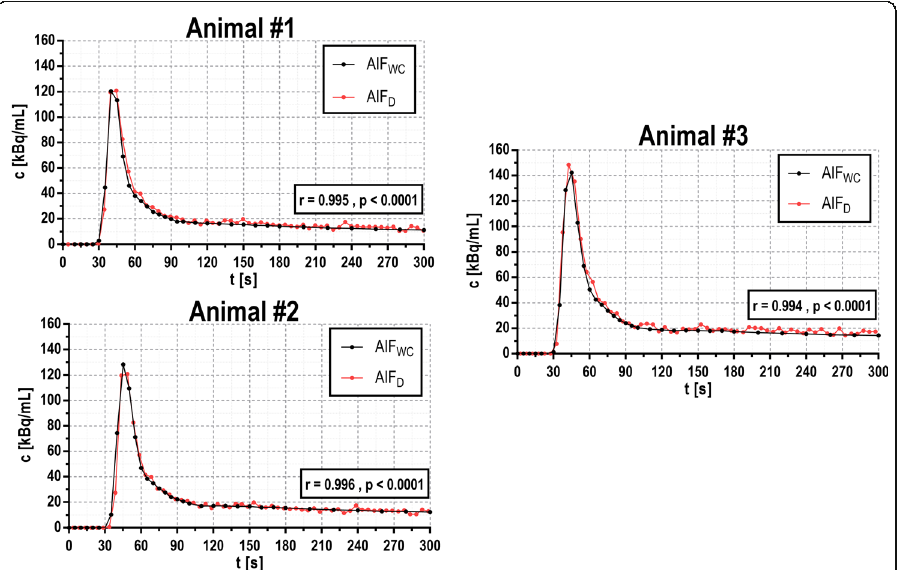
Fig. 5 AIFs obtained with the detector (AIFD, red curves) compared with the AIFs obtained from collected blood sampling analyzed in a well counter (AIFWC, black curves) on three pigs that were injected with 18FDG. Pearson ’ s correlation obtained in all cases is excellent (mean r = 0.996, p < 0.0001).